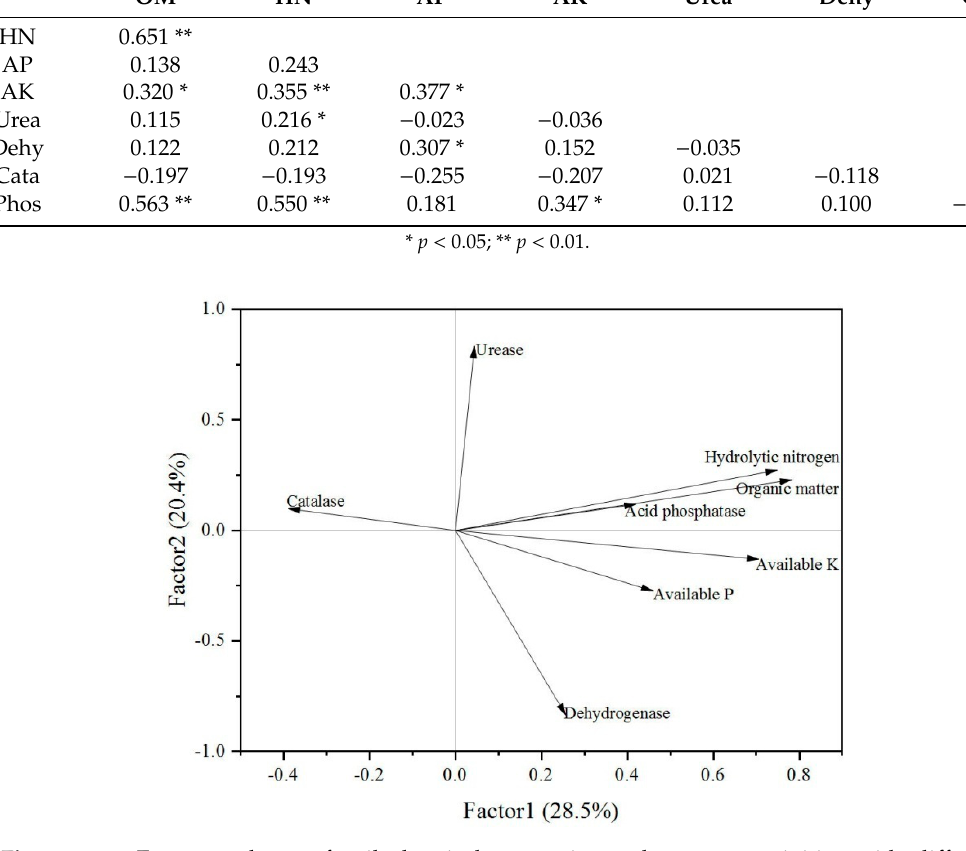
Figure 11. Factor analyses of soil chemical properties and enzyme activities with different graphene treatments.